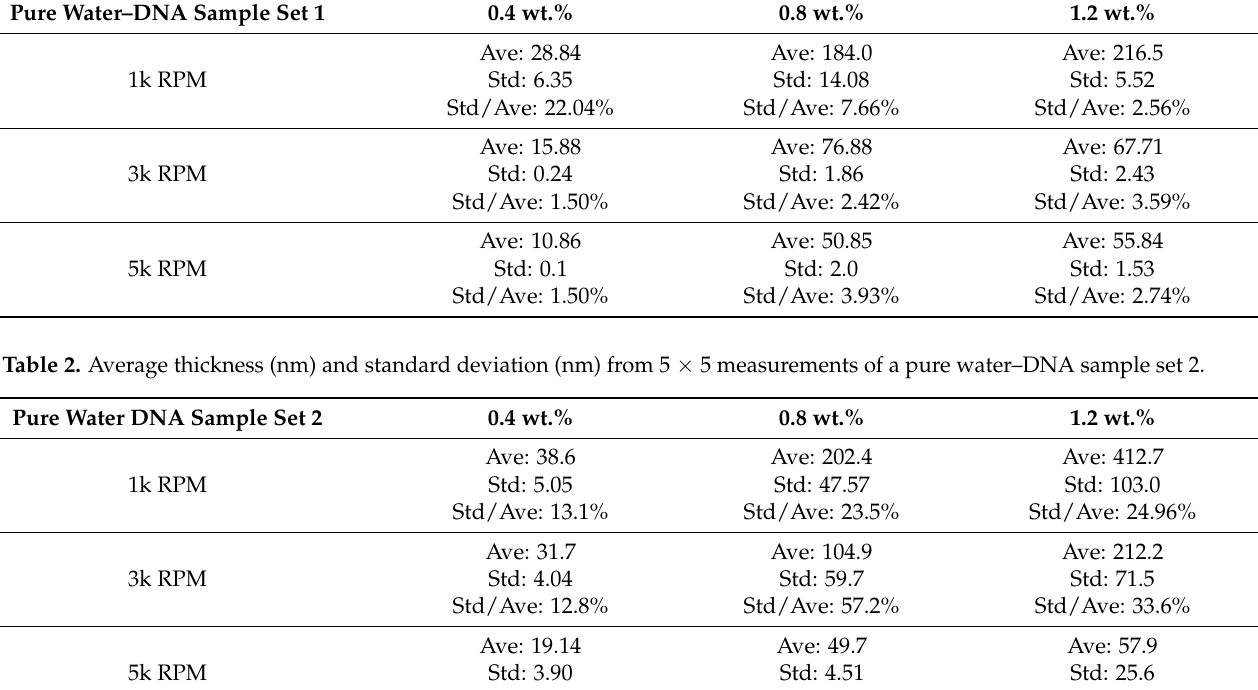
Table 4. Average thickness (nm) and standard deviation (nm) from 5 × 5 measurements of 1:1 MeOH/H 2 O DNA solution. An amount of 2 mL of aqueous DNA with varying DNA concentrations diluted with 2 mL of methanol solvent.